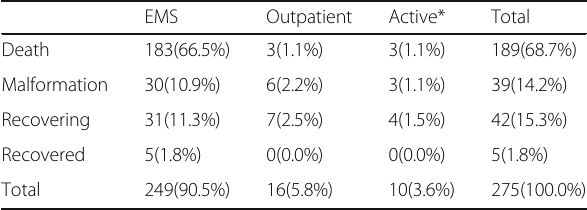
Table 1 Frequency distribution and type of plaintiff ’ s primary reference to the therapeutic center according to the situation of the plaintiff